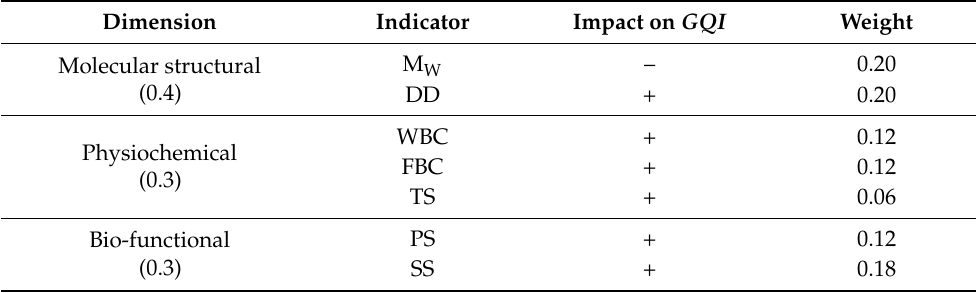
Table 6. Content and weight coefficient of chitosan chemistry performance indexes.